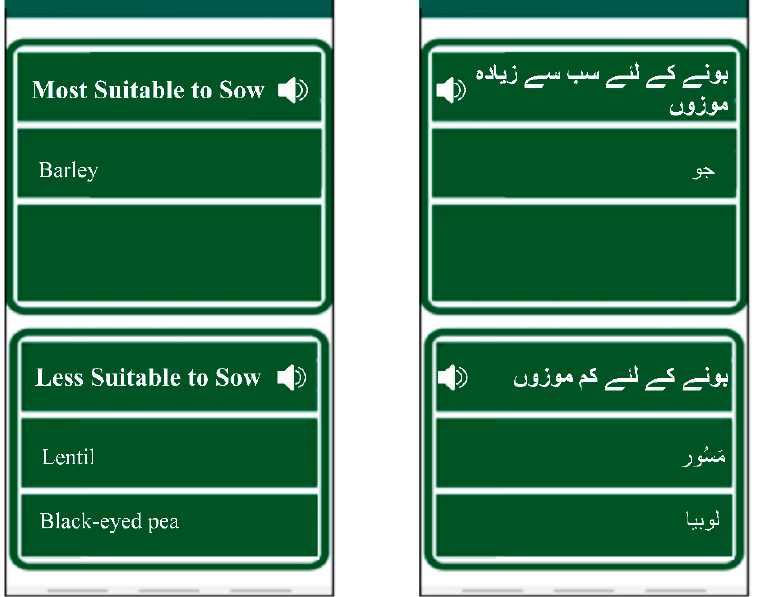
Figure 4. List of Recommended Crops.